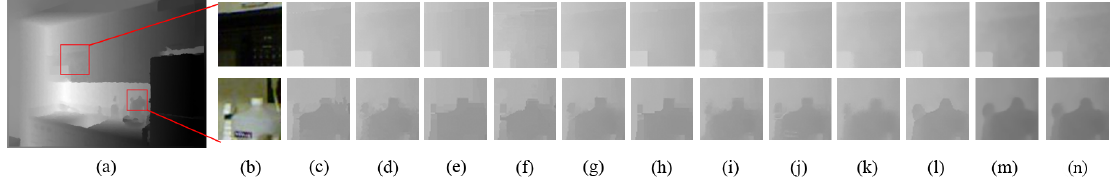
Figure 12. Example depth map SR results of Kitchen1 with two ROI. ( a ) Ground truth depth map, ( b ) color regions, and SR results of ( c ) Diebel et al. [22] (BP% = 3.45) , ( d ) JBU [11] (2.30) , ( e ) Lu et al. [23] (2.32) , ( f ) Kim et al. [24] (2.24) , ( g ) Jung [17] (2.00) , ( h ) Lo et al. [3] (1.45) , ( i ) Park et al. [26] (2.21) , ( j ) Ferstl et al. [27] (1.76) , ( k ) Choi et al. [18] (1.86) , ( l ) Lo et al. [21] (1.16) , ( m ) Our method (0.48) , and ( n ) the associated ground